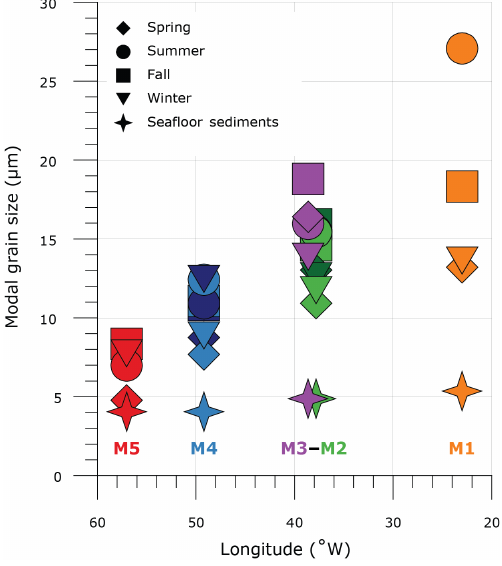
Figure 3. Downwind fining and seasonality in average modal grain size per season for all seven traps (an average of all modal values from the relative volume grain-size distributions, grouped per sea- son), for October 2012–November 2013, and modal grain size of the seafloor sediments (from the grain-size distributions as shown in Fig. 4b) vs. western longitude. For M2 (green) and M4 (blue), lighter colors indicate the upper (1200m) trap, and darker colors indicate the lower (3500m)